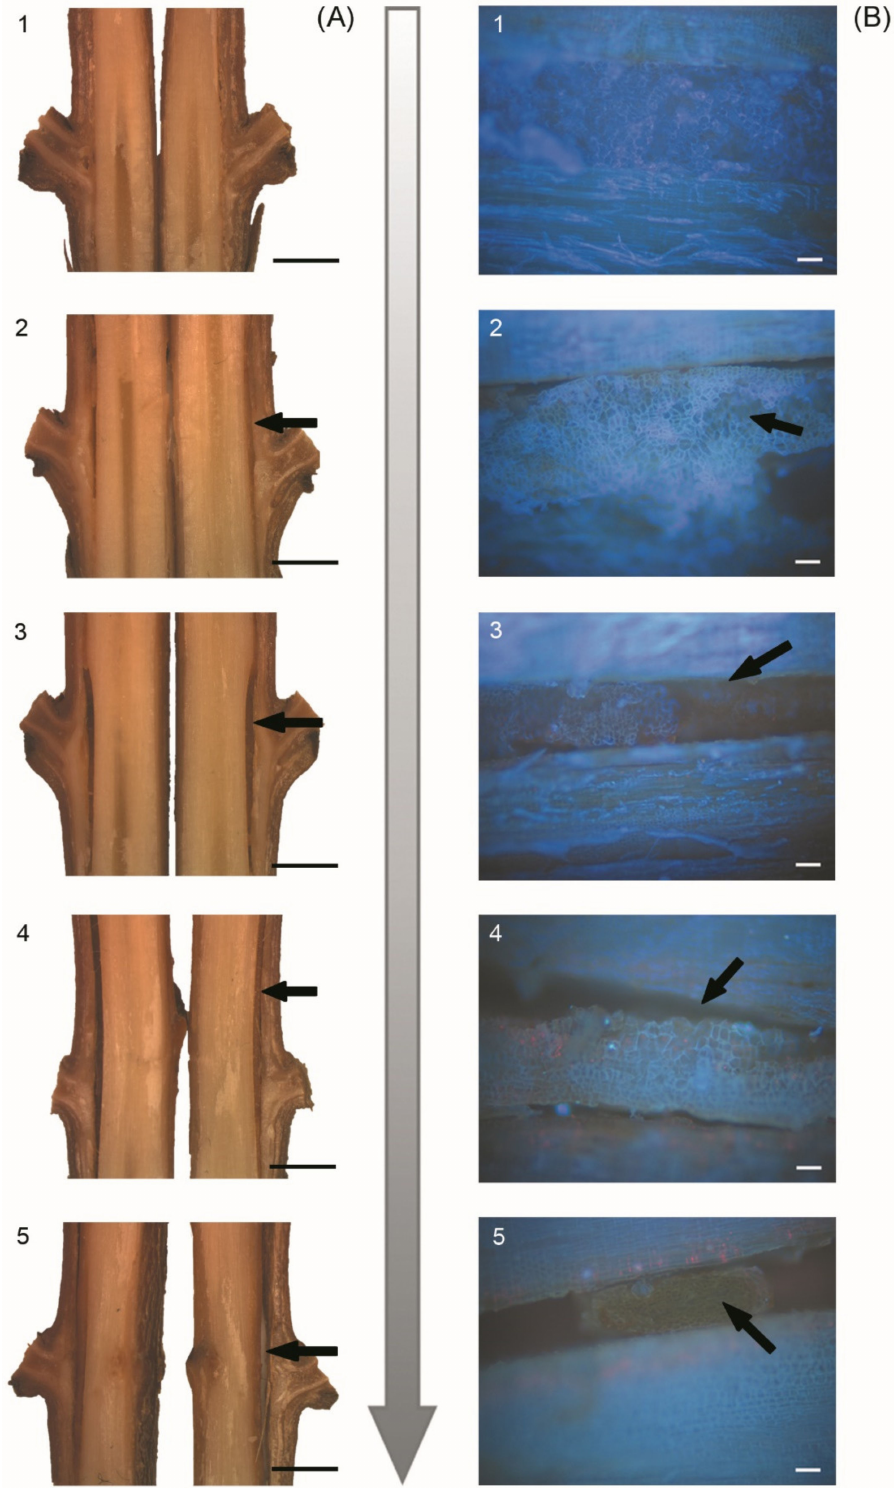
Figure 2. Phenotypic scoring from compatible to incompatible graft combinations. ( A ) Category representation for the stereomicroscope from 1 = absence necrosis (graft compatible plants) to 5 = maximum level of necrosis (graft incompatible plants). Black arrows show the necrotic line (Bars = 2 mm) ( B ) Microscope classification at the graft interface after staining with calcofluor (Bars = 200 µ m). Different degree of callus cell proliferation at the graft interface from score 1 = compatible union to score 5 = incompatible union. Numbers at the top right of the images indicate the phenotypic